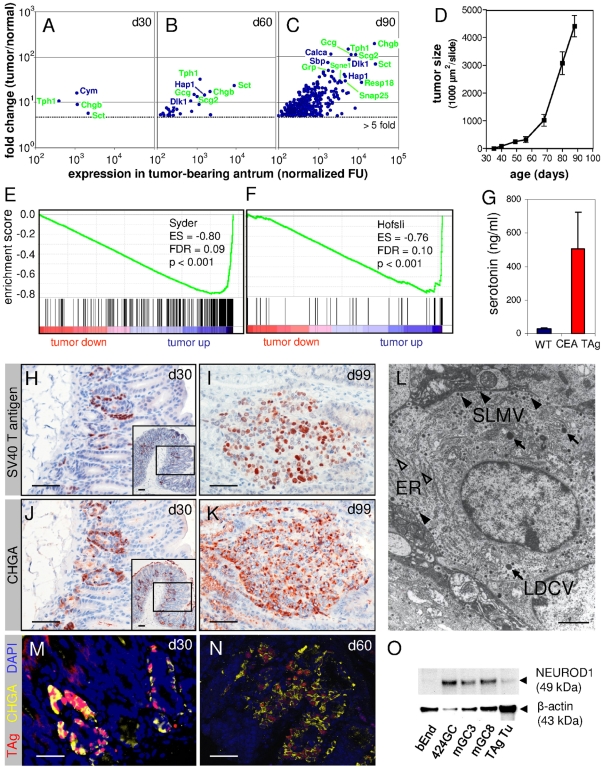

CEA424-SV40 TAg gastric tumors exhibit a neuroendocrine phenotype.Transcriptome analysis of RNA from tumor-bearing regions of the antrum from 30- (A), 60- (B) and 90-day-old CEA424-SV40 TAg-transgenic mice (C) and non-transgenic mice revealed predominant enrichment of genes typically expressed in neuroendocrine tissues (symbols shown in green). The means of the expression levels of genes preferentially expressed in tumor-bearing stomach tissues were plotted against their expression ratio tumor/normal stomach (genes with fold change >5-fold are shown; n = 3). The most strongly upregulated and most highly expressed genes in the samples are identified by gene symbols. These were statistically significant for day 90 (p<0.05). Note the strong increase of upregulated genes with age which reflects the exponential tumor growth between d30 and d90 in CEA424-SV40 TAg transgenic mice (D). (E, F) Gene set enrichment analysis (GSEA) of the d90 tumor ranked gene list using the neuroendocrine signature genes from murine Atp4b-SV40 TAg gastric tumors ([4]; E) and from human neuroendocrine tumors ([15]; F) comprising 305 identifiable genes out of 399 genes and 39 identifiable genes out of 52 genes, respectively. ES, enrichment score; FDR, false discovery rate; tumor up/down, signature gene sets up- or downregulated in tumors. (G) Tumor-bearing transgenic mice exhibit elevated serum serotonin levels. Serum from wildtype (n = 6 pooled; age: 130 d) and CEA424-SV40 TAg mice (n = 6; age: 95–110 d) were analyzed by ELISA. (H–K) Gastric tumor cells express both SV40 TAg (brown nuclear staining; H, I) and the neuroendocrine marker chromogranin A (CHGA; brown cytoplasmic staining; J, K). Parallel sections of formalin-fixed paraffin-embedded gastric tumors from 30- and 99-day-old mice were used for immunohistological staining. The tumors were localized in the antrum and duodenum, respectively. Latter tumors were commonly observed in mice older than 90 days and are supposed to have originated from pyloric tumors through invasive growth or metastatic spread. (M, N) Double-staining with fluorescently labeled anti-SV40 TAg and CHGA of gastric tumor-bearing tissue from 30- and 60-day-old mice. Note most of the cells with SV40 TAg-positive nuclei (red color) express CHGA (yellow color). The nuclei are visualized by DAPI (blue color). Bars: 50 µm. (L) Transmission EM of a typical tumor cell in a tumor from a 90-day-old CEA424-SV40 TAg mouse. Note the numerous electron-dense secretory granules (LDCV, large dense core vesicles, arrows; SLMV, small synaptic-like microvesicles arrowheads) and extended mesh of rough endoplasmic reticulum (ER; open arrowheads) typical of neuroendocrine and rapidly growing cells, respectively. Original magnification: ×15.300 in (L). Bars: 50 µm in H-K; 2 µm in L. (O) Western blot analysis of NEUROD1 expression in CEA424-SV40 TAg tumor-derived cell lines (424GC, GC3, GC8) and in tumors from 85-day-old mice. The endothelioma cell line served as a negative control, detection of β-actin as loading control.